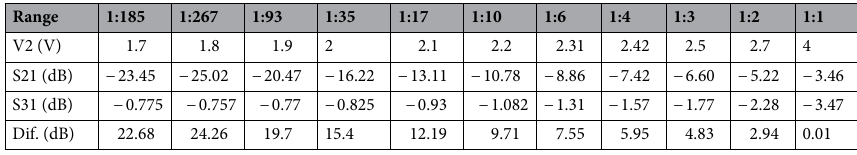
Table 2. Important ranges of divided power for second design TWPD at V1 = 4.